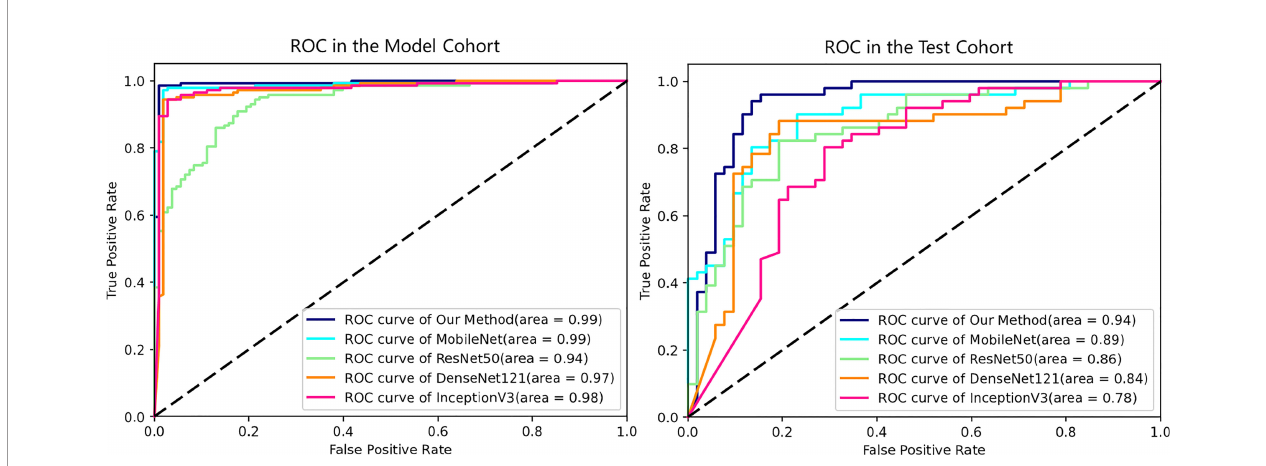
FIGURE 5 | ROC curves of all deep learning models in the model and test cohorts. All methods showed excellent AUCs in model cohort, while the ROC curves in test cohort re fl ect the diagnosis pressure of lesions in similar clinical backgrounds on different DL methods. ROC, receiver operating characteristic; AUC, area under the ROC curve; DL, deep